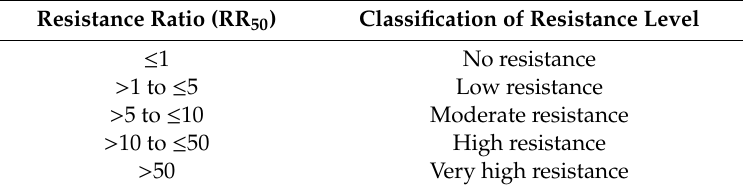
Table 3. Classification of resistance level based on resistance ratio (RR 50 )